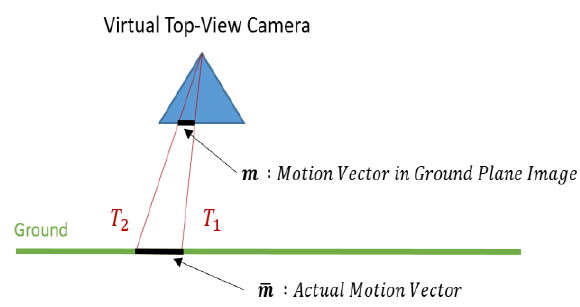
Figure 8 . Illustration of motion vector in Ground Plane Image and actual motion vector